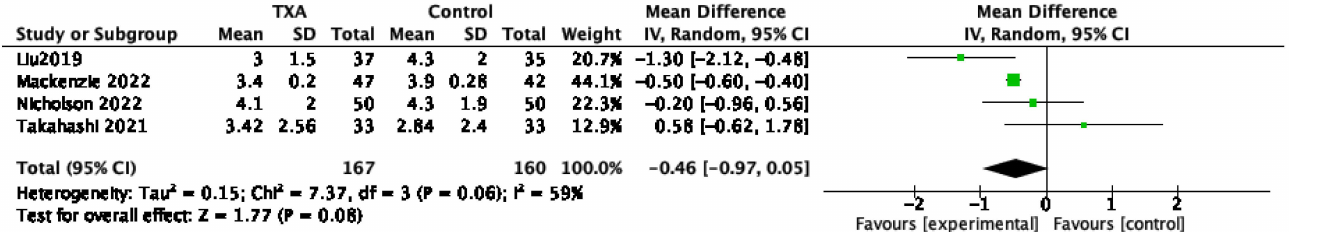
Figure 5. Forest plot and meta-analysis of VAS one day post operation.The centre of each square represents the weighted mean differences for individual trials, and the corresponding horizontal line stands for a 95% confidence interval. The diamonds represent pooled results [11,14,15,20].